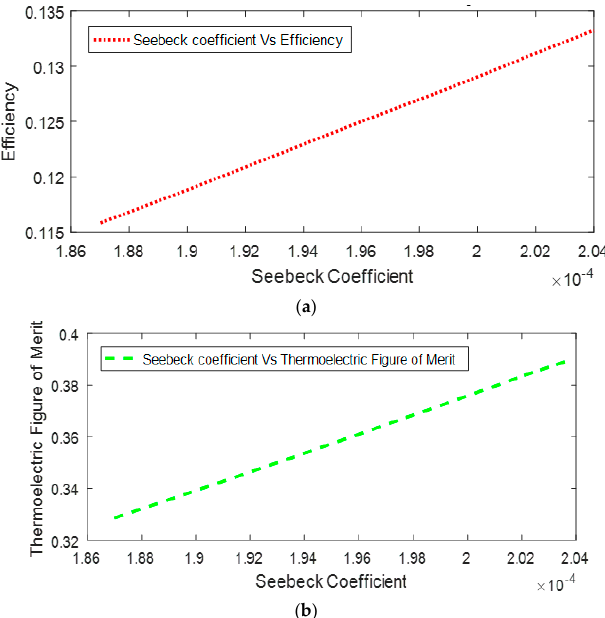
Figure 10. ( a ) Effect of increasing Seebeck coefficient from 1.85x10 -4 to 2.04x10 -4 on (a) efficiency and ( b ) figure of merit 𝑍𝑇(cid:3364) showing an increase of efficiency from 0.11 to 0.13 and an increase of 𝑍𝑇(cid:3364) from 0.32 to